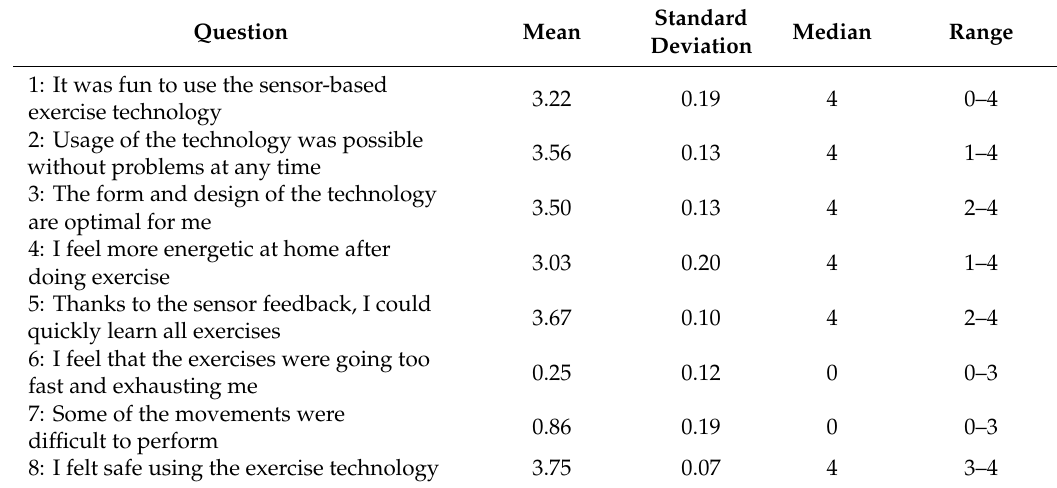
Table 2. Results of the user experience questionnaire.